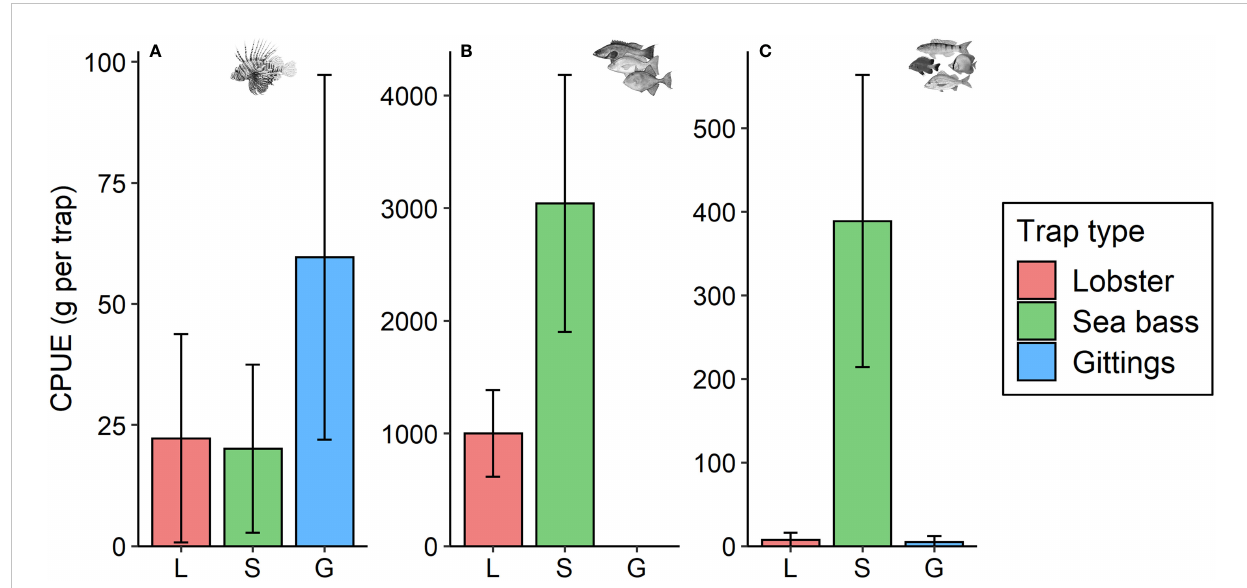
FIGURE 6 Catch per unit effort (CPUE) by trap type. Mean (± 95% CI) CPUE per trap is shown for (A) lion fi sh, (B) native fi shery species, and (C) native non- fi shery species captured with each of three experimental trap types (lobster, sea bass, or Gittings traps) deployed near mesophotic reefs in the northeastern Gulf of Mexico. Note scale differences among